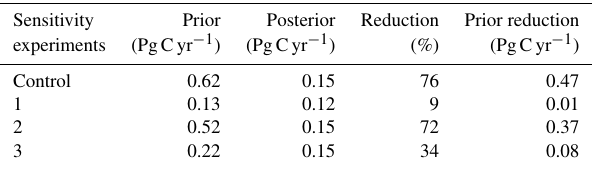
Table 7. Prior and posterior uncertainties (in PgCyr − 1 ) for an en- semble of five realizations.